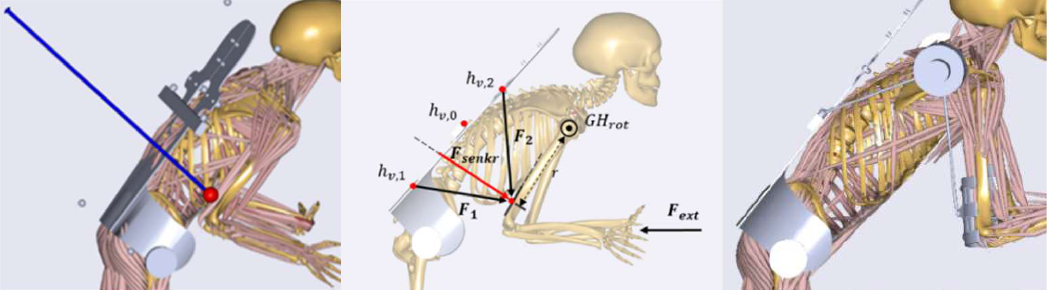
Figure 12. Exoskeleton–human models with outlined artificial force in blue for abstract optimal support estimation ( left ), varying back module attachment locations for mechanism to find optimal configuration ( middle ) and final concept with implemented design ( right ).